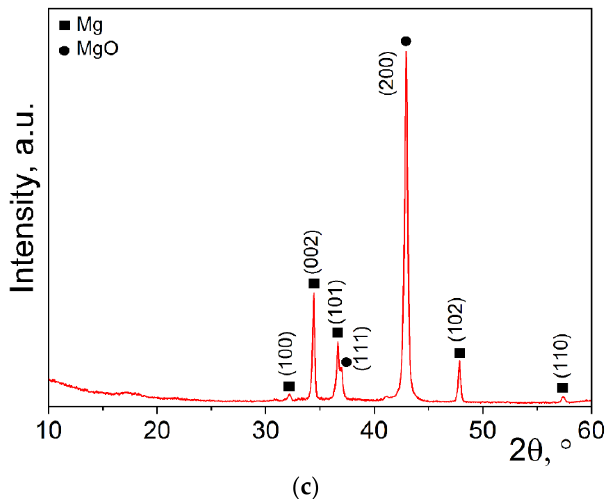
Figure 6. Characterization of the composition of the surface layer for the superhydrophobic coating: ( a ) EDS spectrum; ( b ) Fourier-transform infrared reflectance spectra; ( c ) XRD spectrum. Blue lines in ( a ) and ( b ) correspond to the as-prepared sample, red lines to the sample after immersion in 0.5 M NaCl solution for 30 d; XRD spectra ( c ) were the same for the samples before and after the immersion.